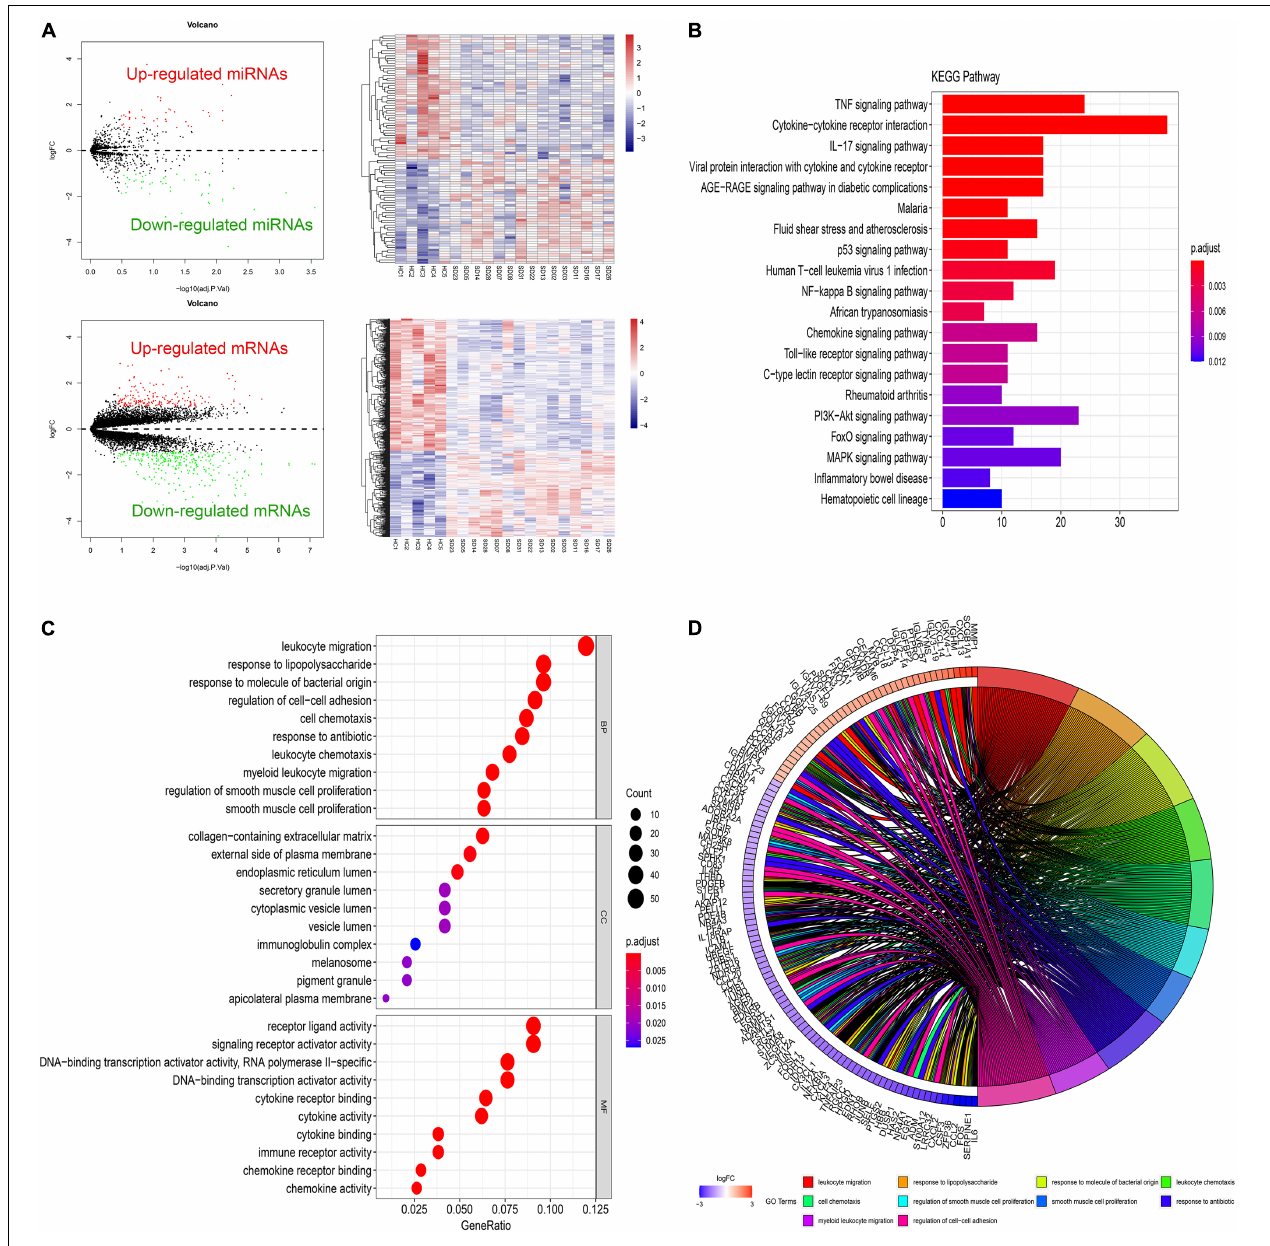
FIGURE 2 | Differential expressed gene profiles analysis. (A) Volcano and heatmap plots of DEGs and DEmiRs in GSE81293 and GSE81292. (B) The top 10 KEGG enrichment pathways of DEGs in GSE81292. The length of each bar means the amounts of genes that belong to one certain pathway. The different color of each bar means P -adjust-value. (C) Top 10 biological process (BP), cellular component (CC), and molecular functions (MF) terms of DEGs in GSE81292. The size of each circle means the amounts of genes. The different color of each circle means P -adjust-value. GeneRatio means the ratio of genes that belong to this pathway divided by the number of genes in the background gene cluster that belong to this pathway. (D) GOchord plot of DEGs in GSE81292. DEG, differential expressed genes; DEmiRs, differential expressed miRNAs; KEGG, Kyoto Encyclopedia of Genes and Genomes; GO, gene